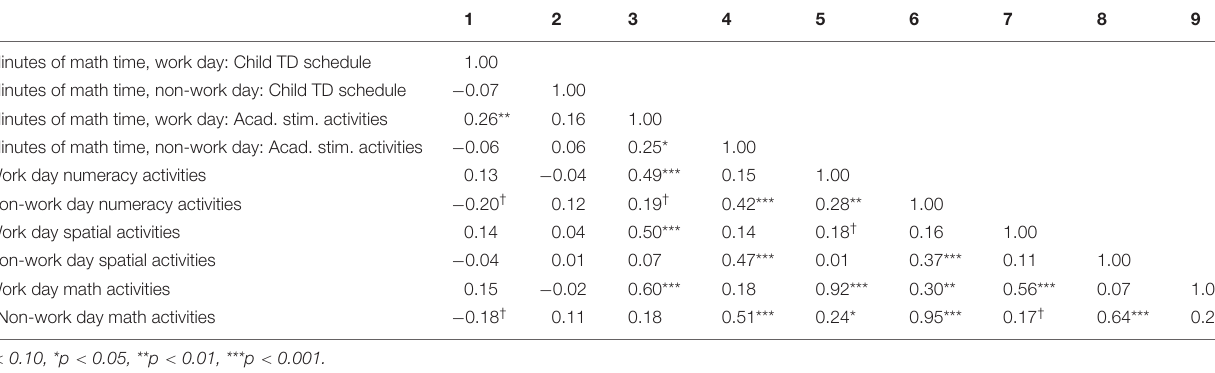
TABLE 8 | Pair-wise correlations among reports of time in math activities and counts of numeracy, spatial, and overall math activities from time diary interviews. 1